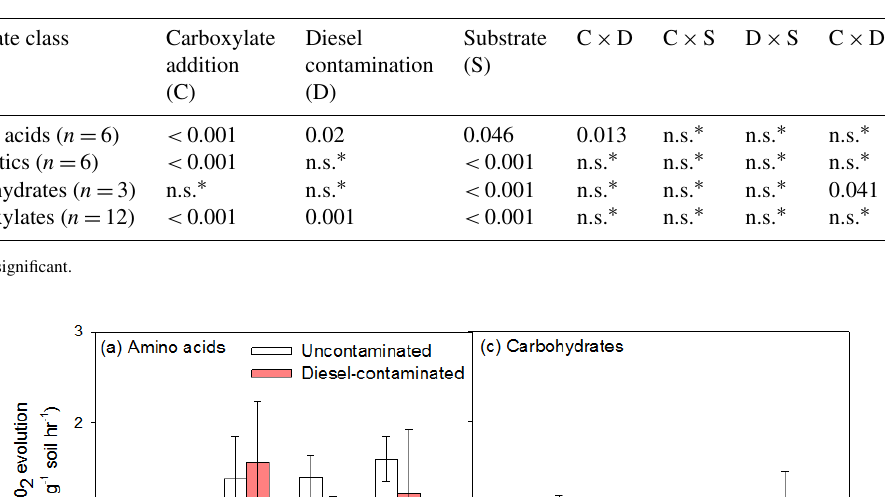
Table 1. Outcomes of a three-way analysis of variance on the community-level physiological profiles (CLPPs) after an 18-day incubation of diesel-contaminated and uncontaminated soils which received water or 5µmolg − 1 soil of malonate, citrate + malonate, or citrate every 48h.